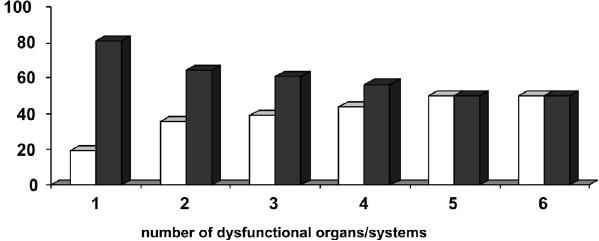
Figure 3 - Percentage of patients with a diagnosis of sepsis made by the ED team according to the number of dysfunctional organs. White columns: percentage of patients with sepsis diagnosis; black columns: percentage of patients without diagnosis. Chi-square test (p=0,006)